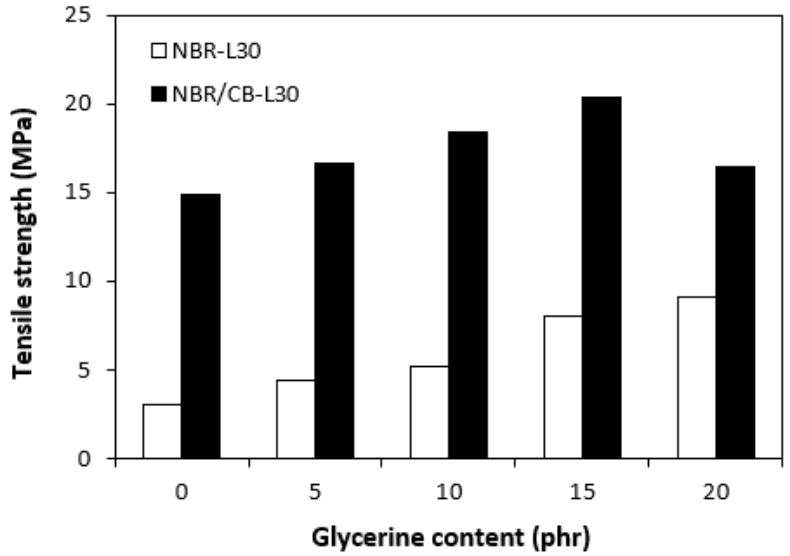
Figure 16. Influences of glycerine contents on tensile strengths of vulcanizates.